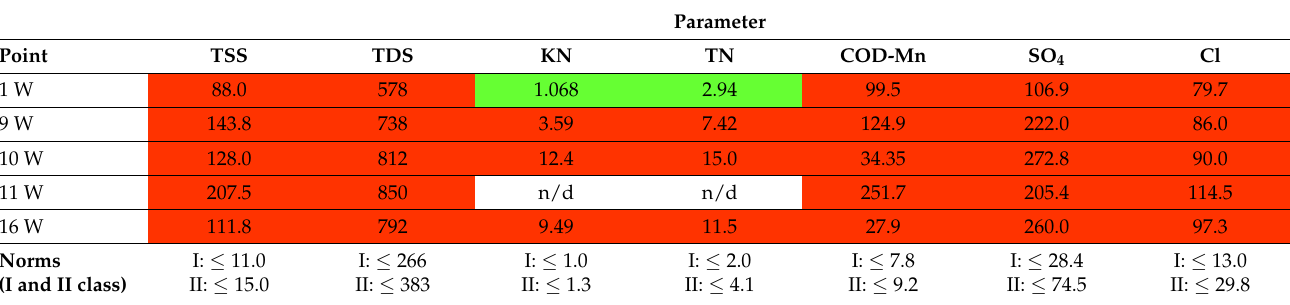
Table 9. The state of physicochemical elements at points tested by WIO´S